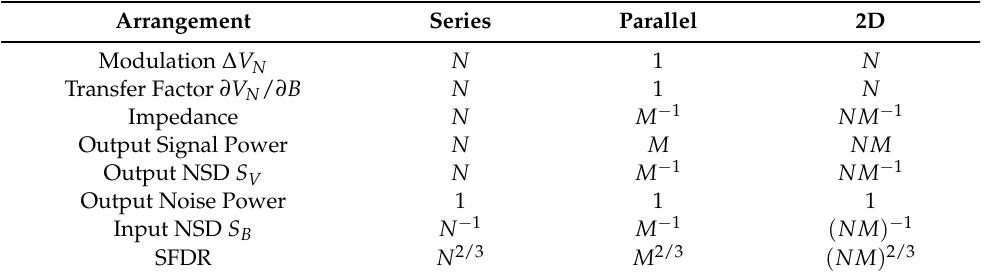
Table 1. Scaling of arrays of perfectly identical SQUIDs, delivering the output signal to a matched, i.e., suitably scaled, load. M (resp. N ) is the number of JJs in parallel (resp. in series). The frequency bandwidth to integrate the NSD for power evaluation is assumed independent of N and M .